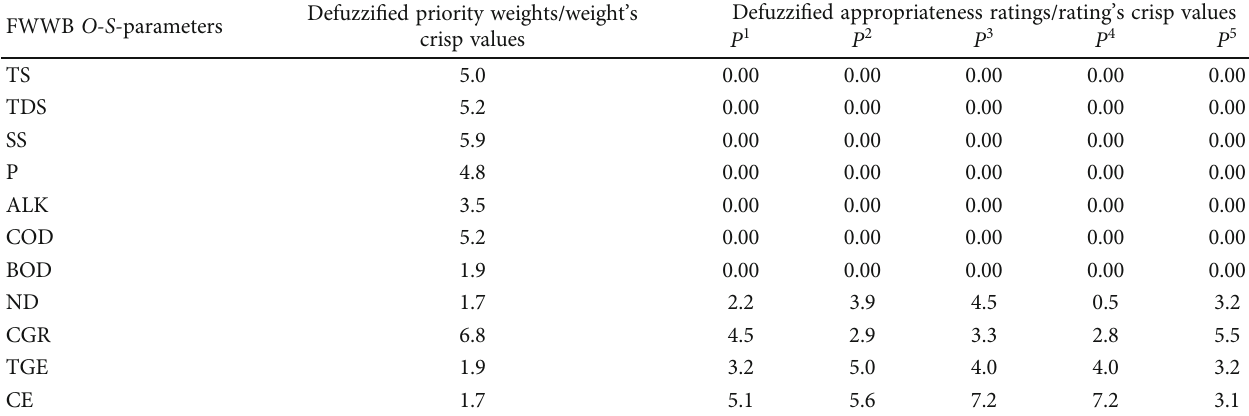
Table 6: Computed defuzzi fi ed crisp values for FWWB O - S -parameters vs. FWWB points.